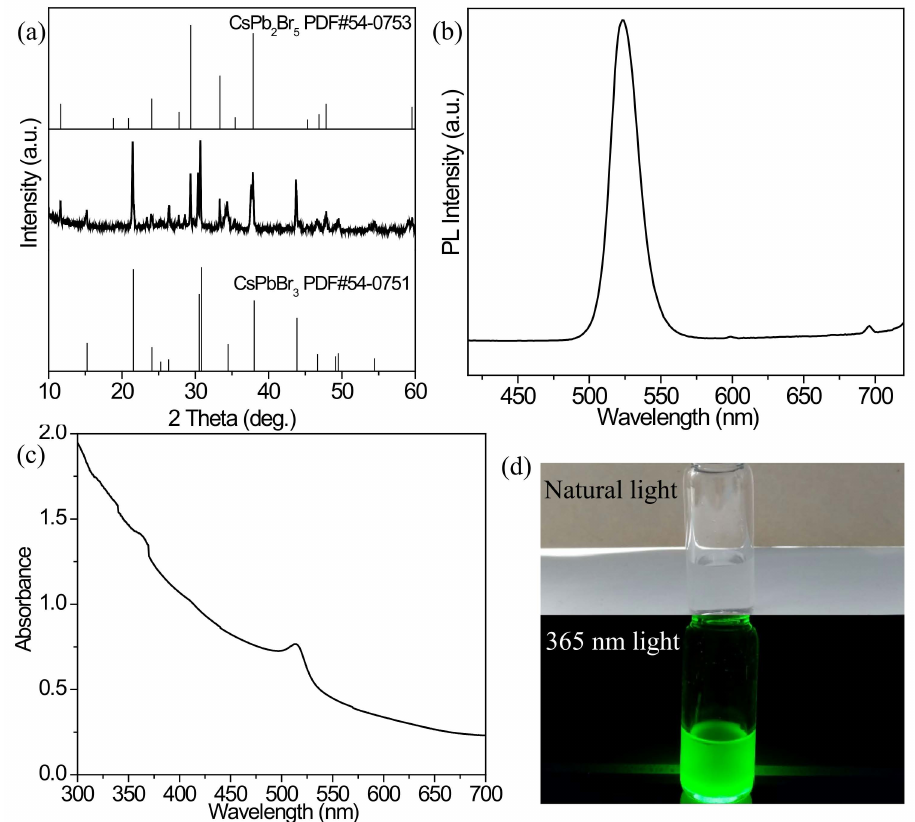
Figure 1. ( a ) XRD pattern, ( b ) PL emission and ( c ) UV-vis absorption spectra of the best pristine CsPbBr 3 achieved under the conditions of Cs 2 CO 3 /PbBr 2 = 0.1/0.45, temperature of 150 ◦ C and ODE/DGBE = 5:5. ( d ) Optical images of the cyclohexane solution containing the best pristine CsPbBr 3 under the environments of natural and 365 nm